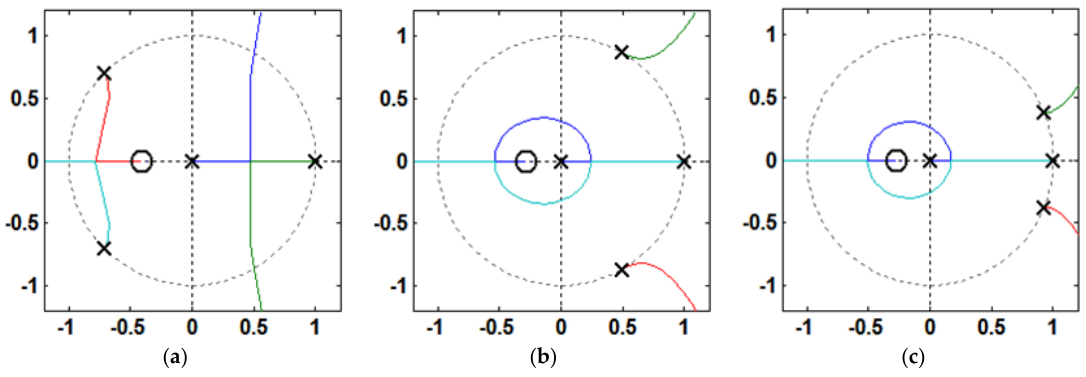
Figure 6. Root loci of the digital single-loop grid-side current control scheme without any damping method: ( a ) high resonant frequency region ( C f = 1 μ F); ( b ) critical resonant frequency ( C f = 5 μ F); and ( c ) low resonant frequency region ( C f = 36 μ F).